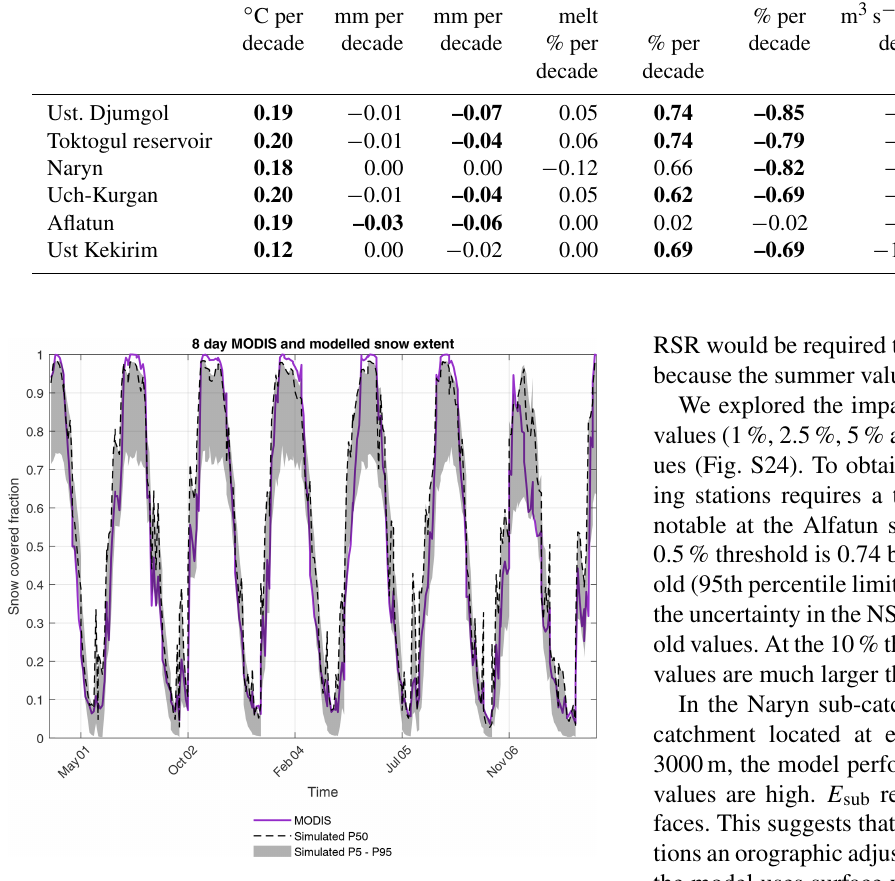
Figure 9. MODIS and simulated weekly fraction of the basin cov- ered in snow. The grey-shaded envelope shows the 5th–95th per- centile range of the best 0.5% calibration